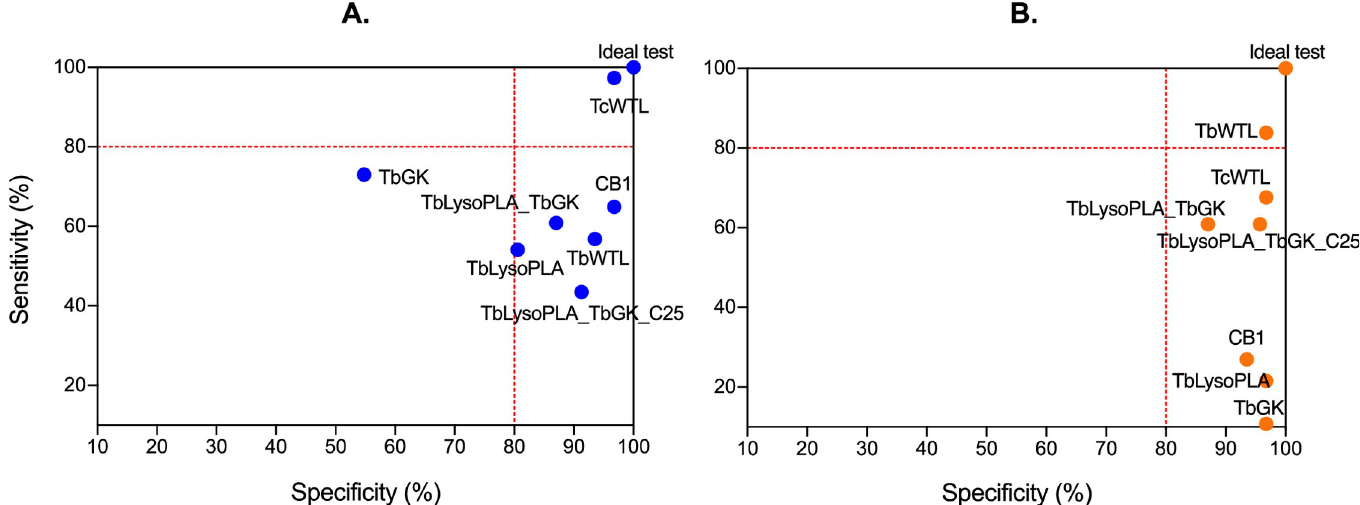
Fig 5. Sensitivity and specificity relationship at optimal cut-off for each test and comparison with controls. (A.) Bovine sera from experimental T. congolense infection. (B.) Field sera from T. b. brucei. T. congolense and T. vivax infected cattle.